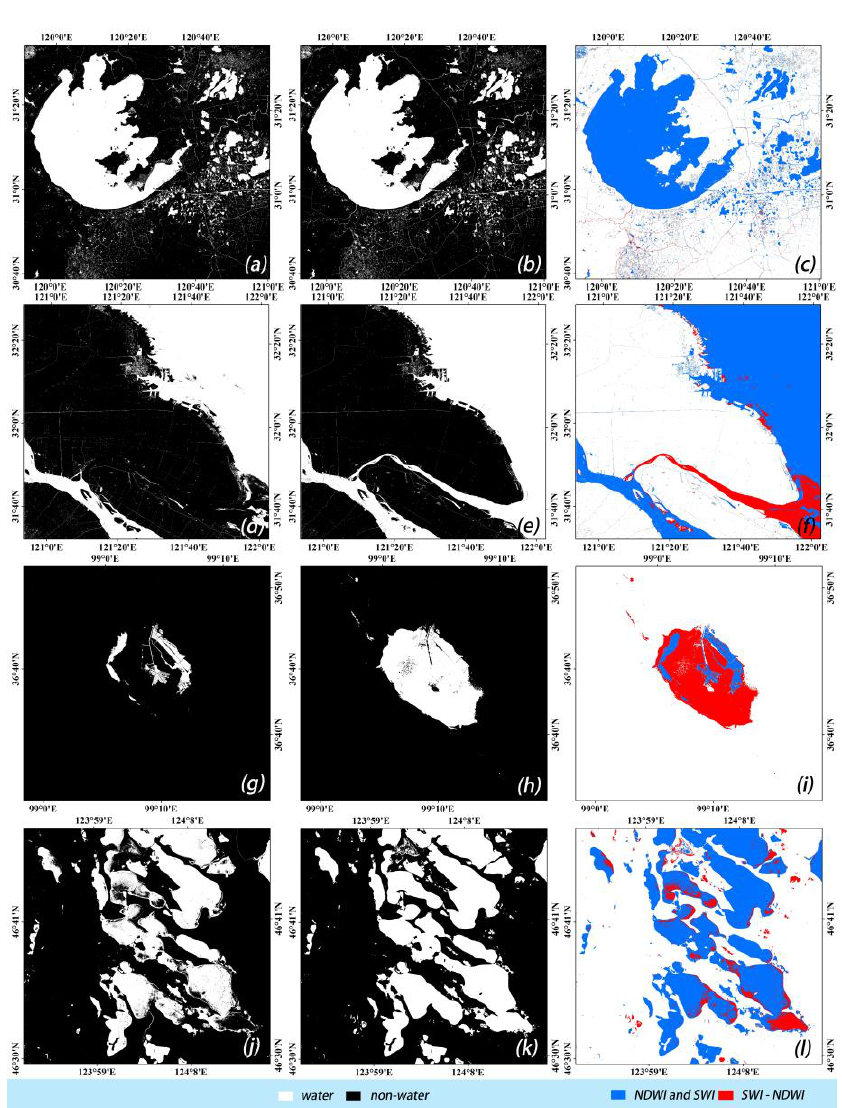
Figure 4. Water extraction of NDWI and SWI index and its difference ((a)(d)(g)(j)respectively represent water bodies extracted by NDWI in Taihu Lake 、 the Yangtze River Estuary 、 ChaKa Saline Lake 、 Chain Lake; (b)(e)(h)(k) respectively represent water bodies extracted by SWI in Taihu Lake 、 the Yangtze River Estuary 、 ChaKa Saline Lake 、 Chain Lake; (c)(f)(i)(l) respectively represent similarities and differences of water body extraction based on NDWI and SWI in Taihu Lake 、 the Yangtze River Estuary 、 ChaKa Saline Lake 、 Chain Lake). Mapping precision User precision Overall